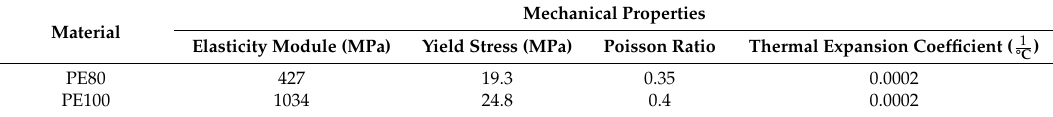
Figure 7. polyethylene pipe and patch arrangement. ( a ) Two dimensional view (dimensions in mm) of the cross section of the medium density polyethylene gas pipe. ( b ) Three dimensional model of patch repaired pipe showing patch dimensions [8–12,41]. Table 3. Mechanical properties of the PE80 pipe and PE100 patch materials [8–12,41].